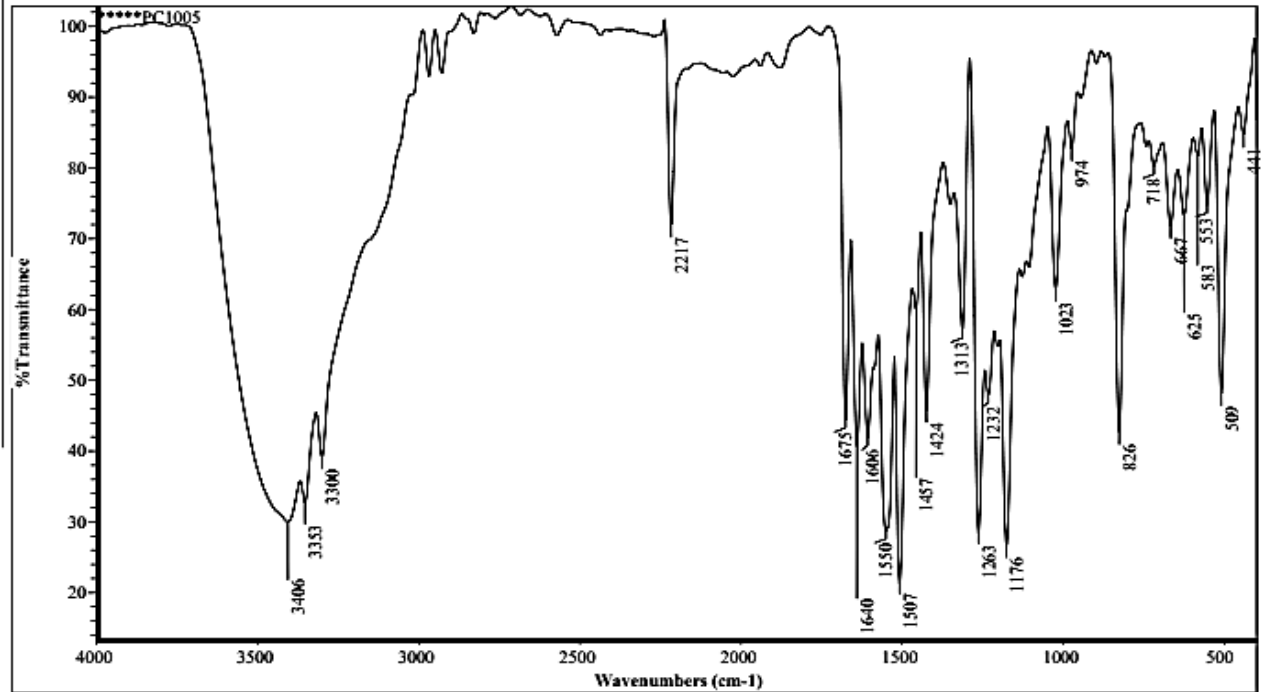
Figure 2. FTIR of